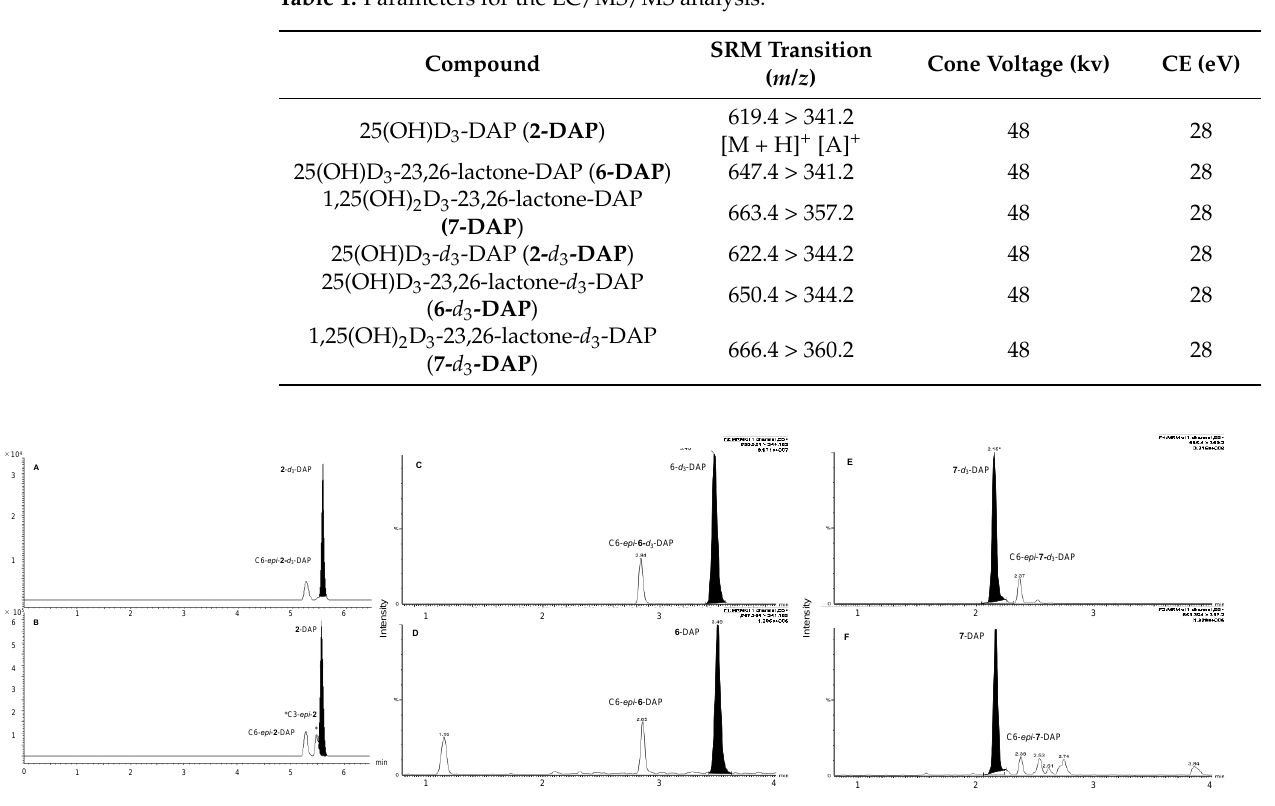
Figure 3. SRM chromatograms for the DAP adducts of D 3 metabolites 2 , 6 , and 7 , as well as 2 -d 3 , 6 -d 3 , and 7 -d 3 .